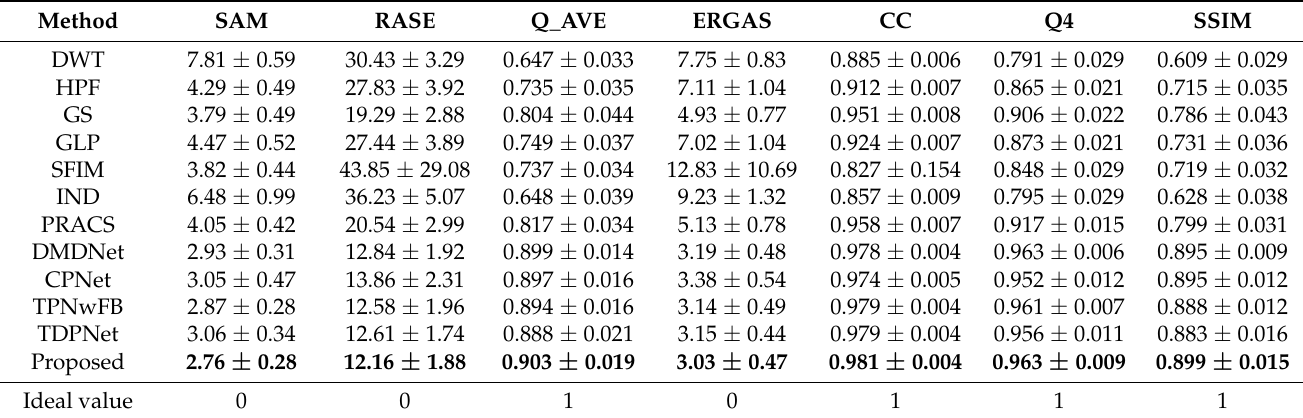
Table 5. Evaluation results on the WorldView-3 dataset (best results in